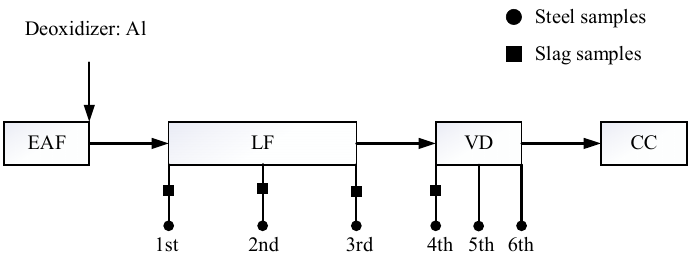
Figure 1. Schematic illustration of smelting process and sampling locations.